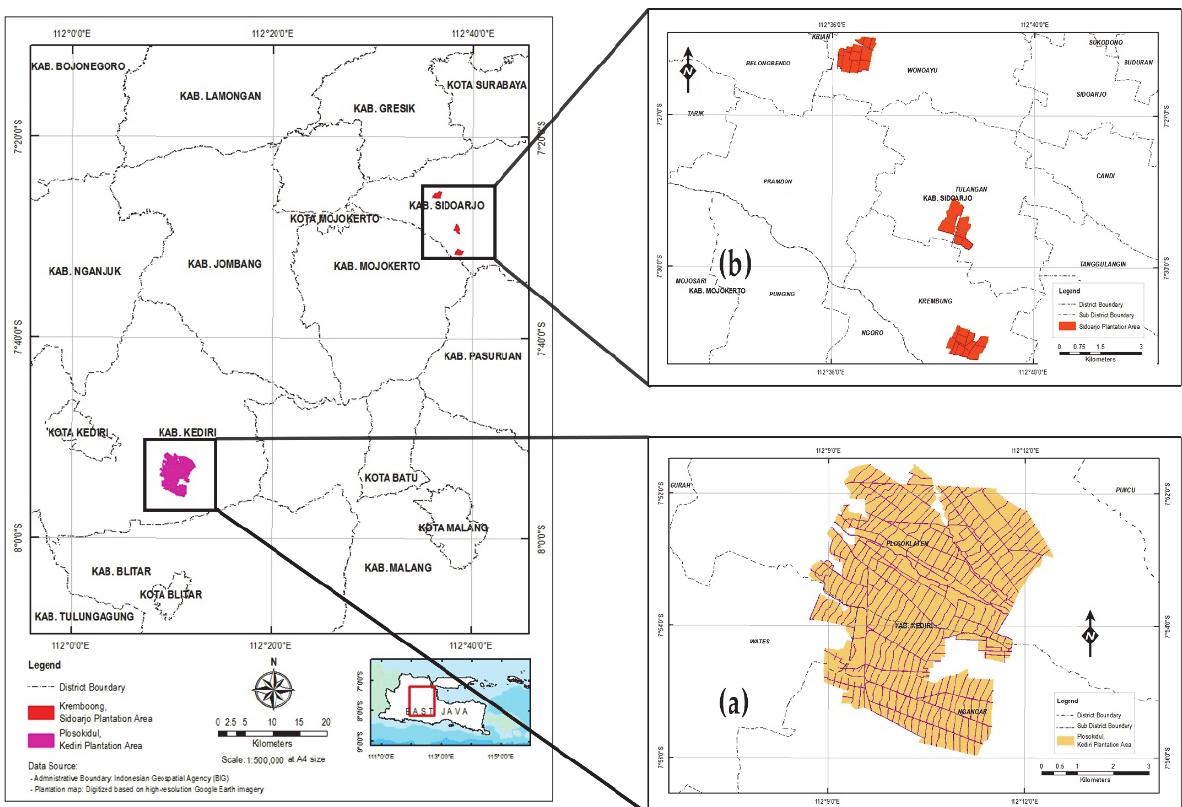
Figure 1. Kediri ( a ) and Sidoarjo ( b ) sugarcane plantation area managed by PTPN X.